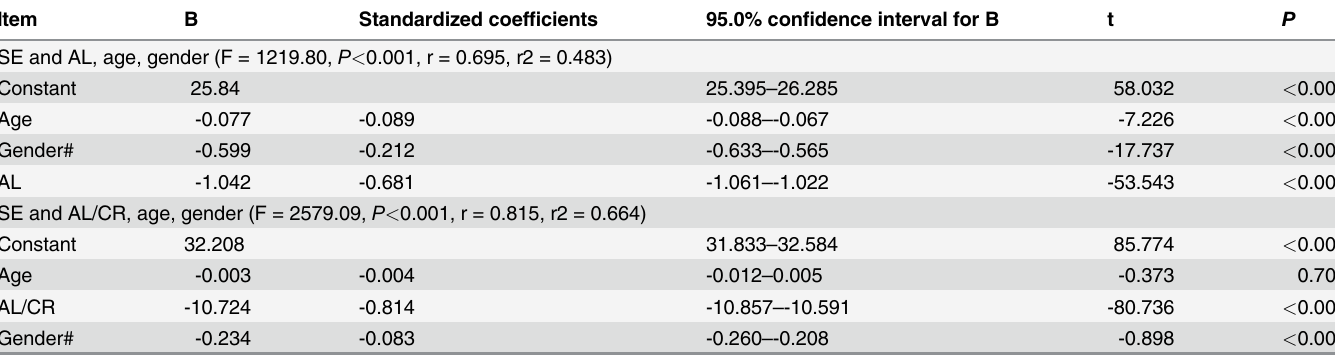
Table 4. Linear regression analysis of SE and AL, AL/CR. Standardized coef fi